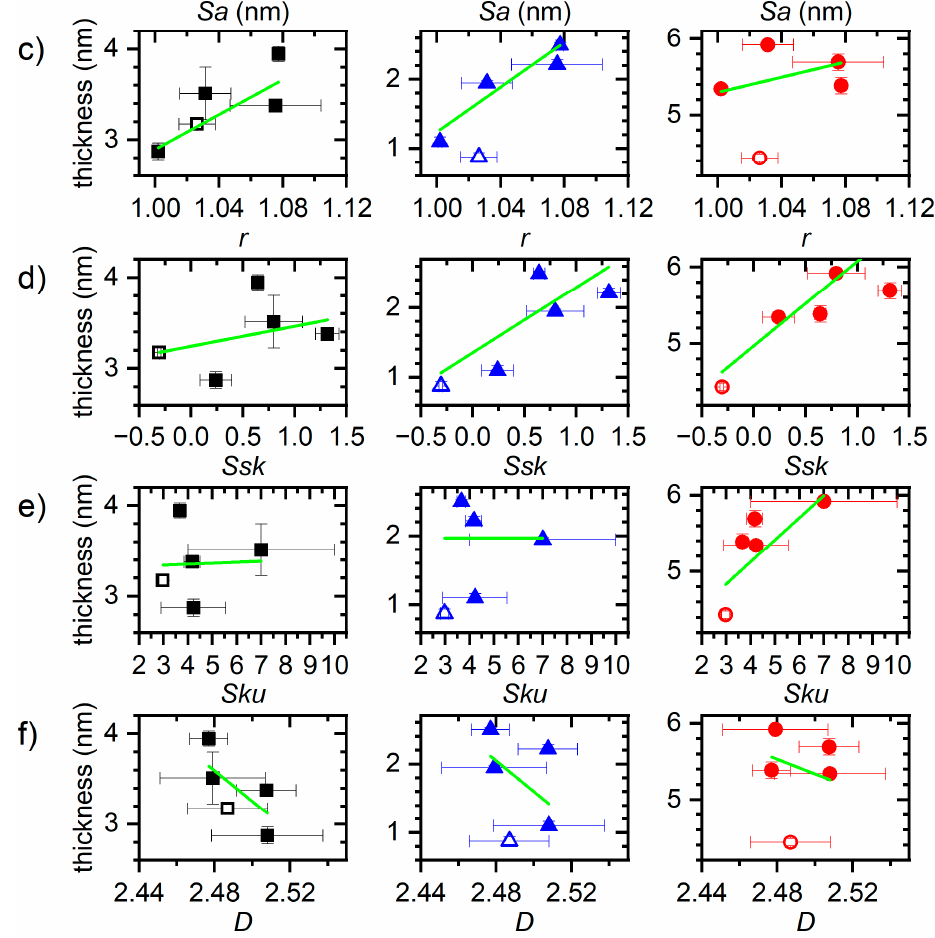
Figure 5. Thickness of the irreversibly adsorbed MGB, BSA, and TGL films determined from the ellipsometry data in Figure 2 versus RMS surface roughness Sq ( a ), arithmetic surface roughness Sa ( b ), roughness factor r ( c ), skewness Ssk ( d ), kurtosis Sku ( e ), and fractal dimension D ( f ). Error bars in x direction reflect the standard deviations given in Table 2, whereas error bars in y direction represent the standard deviations from averaging the thickness values recorded in the last 10 min of the experiment. The nanorippled surfaces (0.07-40-r) are indicated by the empty symbols. The solid green lines represent linear fits to the data.